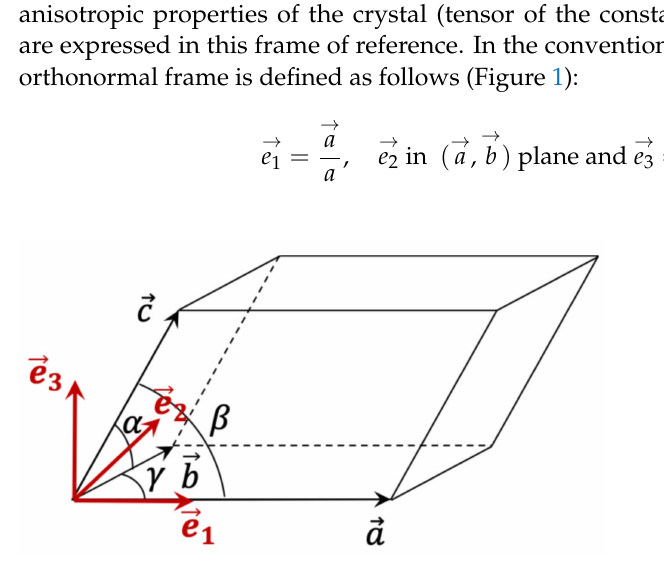
Figure 1. Orthogonal reference basis associated with the unit